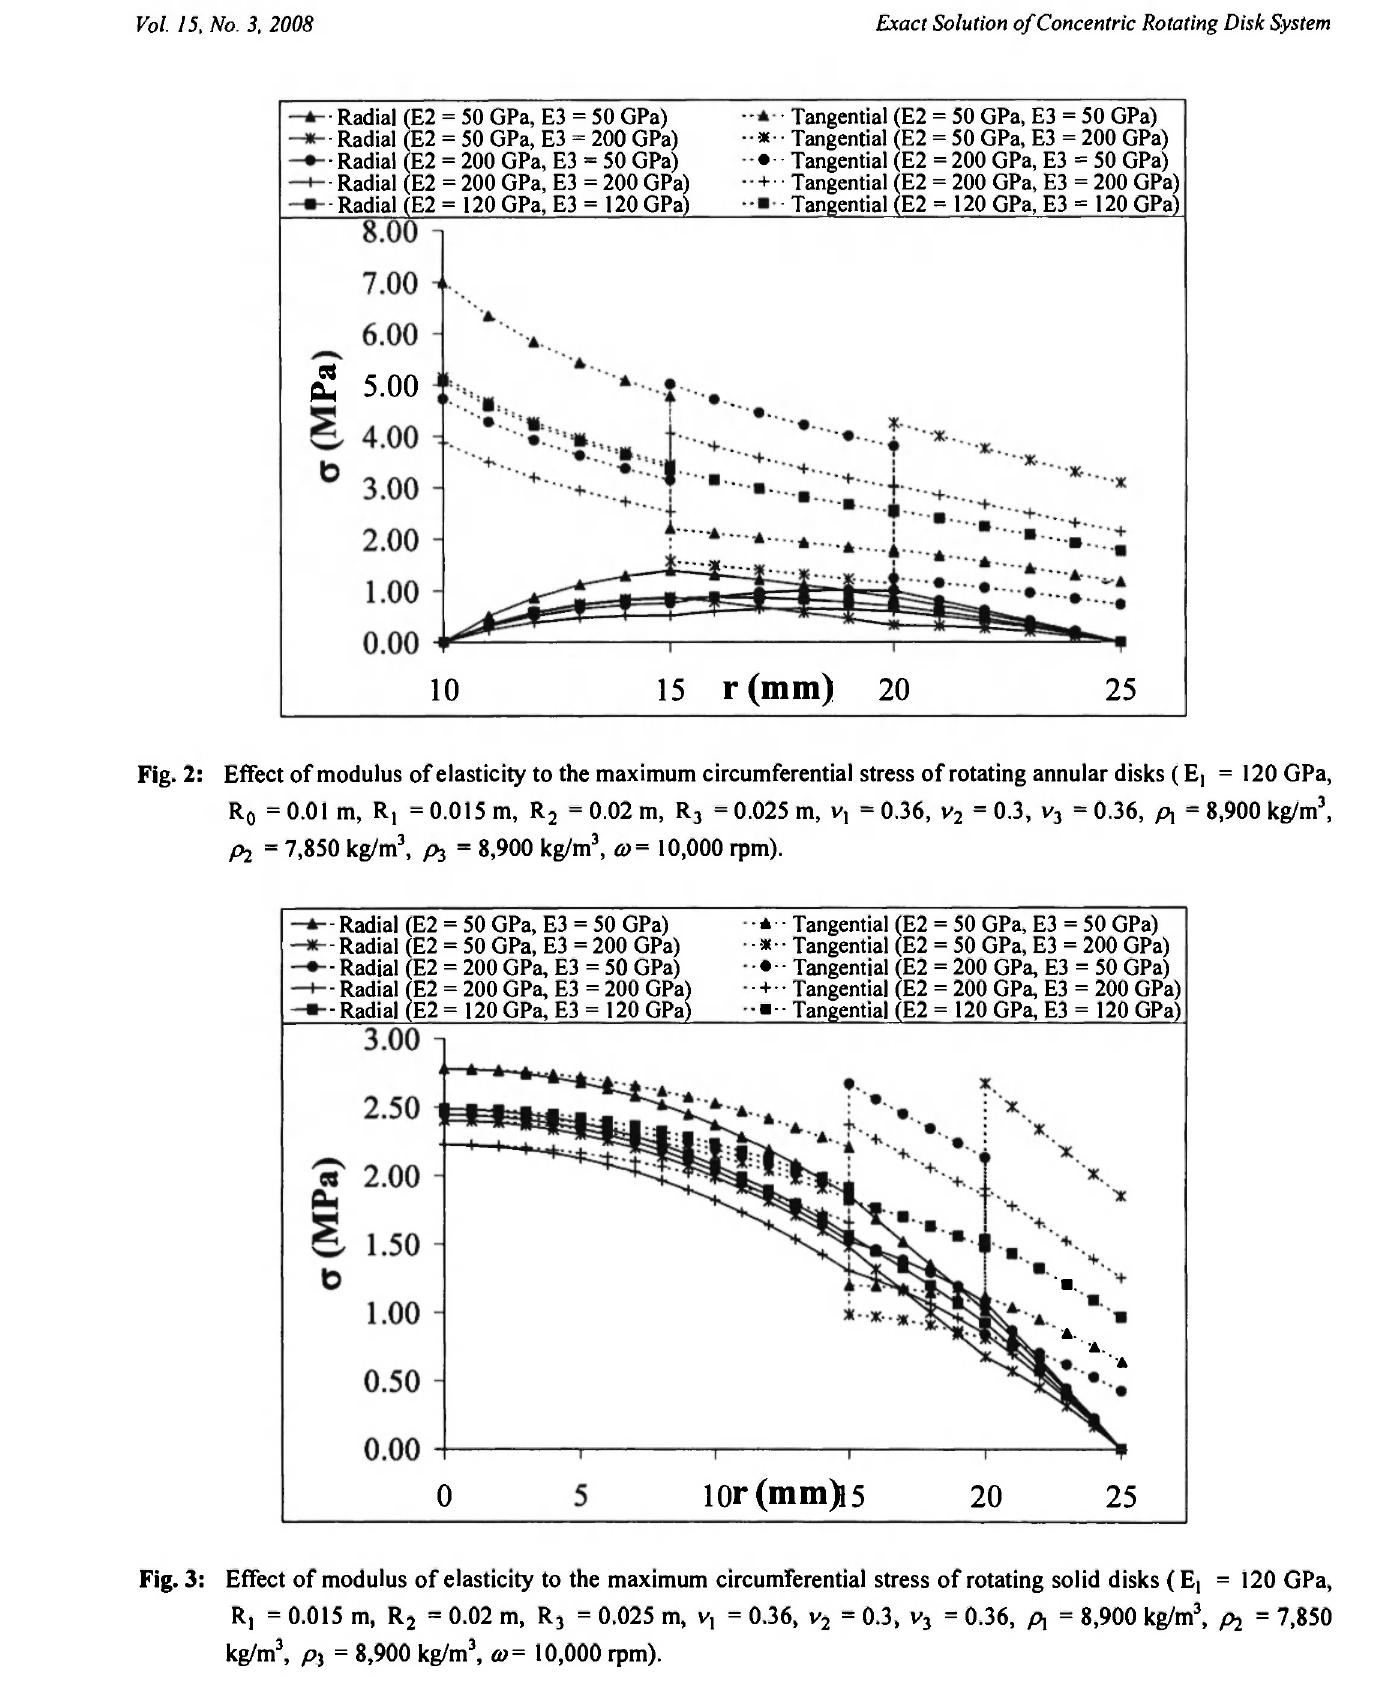
Fig. 3: Effect of modulus of elasticity to the maximum circumferential stress of rotating solid disks (E! =120 GPa, R, = 0.015 m, R 2 = 0.02 m, R 3 = 0.025 m, v, = 0.36, v 2 = 0.3, v 3 = 0.36, p, = 8,900 kg/m 3 , pj = 7,850 kg/m 3 , p, = 8,900 kg/m 3 , a>= 10,000